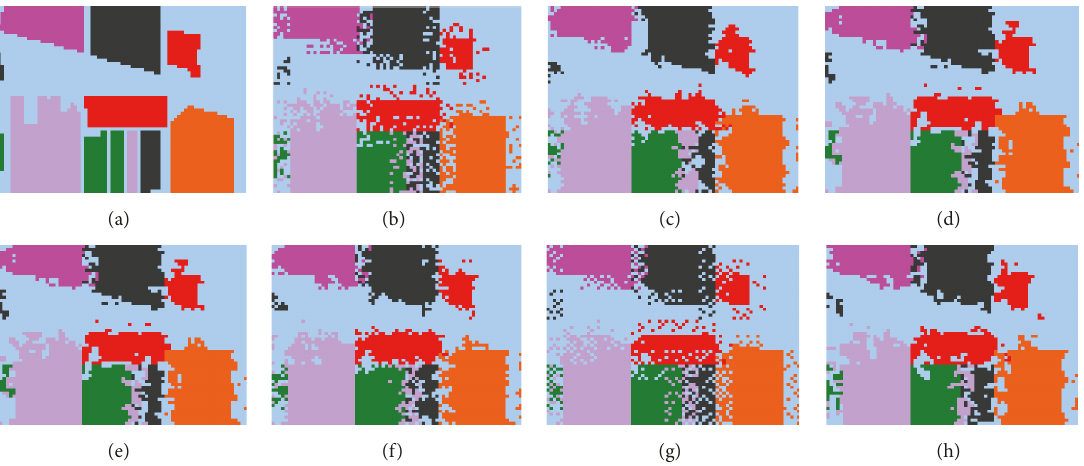
Figure 9: The subpixel mapping results of the 5 × 5 filter image with the six algorithms: (a) true distribution, (b) random distribution, (c) PMBQPSO, (d) CMBQPSO, (e) GMBQPSO, (f) PBQPSO, (g) CBQPSO, and (h)